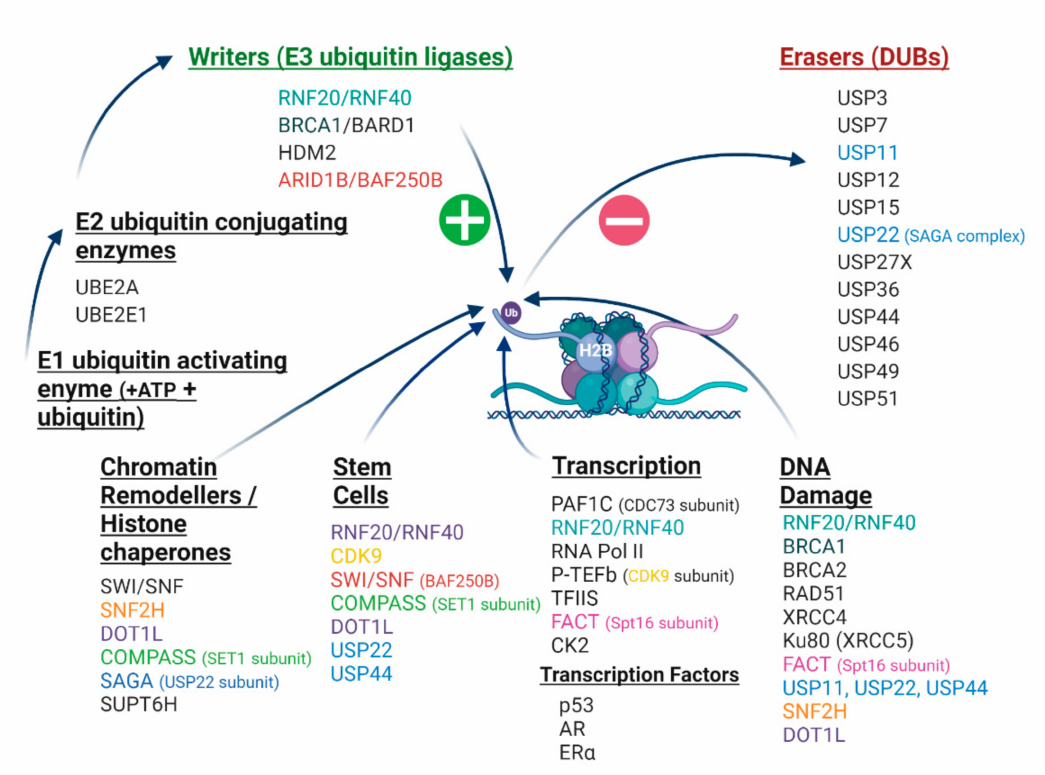
Figure 1. The H2Bub1 interactome. H2Bub1 can be written (green plus symbol) by multiple writer enzymes (E3 ubiquitin ligases) following an enzymatic ubiquitin cascade commencing with an E1 ubiquitin activating enzyme followed by an E2 ubiquitin conjugating enzyme. It can be removed (red minus symbol) by numerous erasing deubiquitinases (DUBs) from the Ubiquitin-Specific Protease (USP) sub-family. H2Bub1 interacts with a number of chromatin remodelling complexes and histone chaperones. Numerous components of the H2Bub1 interactome function in more than one cellular process, such as cyclin-dependent kinase 9 (CDK9) in stem cell plasticity and transcription, identified in this schematic by matching colours. The H2Bub1 interactome continues to be elucidated and is growing as new discoveries are made. Androgen receptor (AR); AT-Rich Interaction Domain 1B (ARID1B); BRG1 / BRM-associated factor (BAF250B); BRCA1-Associated RING Domain 1 (BARD1); Breast Cancer Type 1 (BRCA1); Breast Cancer Type 2 (BRCA2); cyclin-dependent kinase 9 (CDK9); estrogen receptor alpha (ER α ); complex of proteins associated with SET1 (COMPASS); disrupter of telomere silencing 1-like (DOT1L); facilitates chromatin transcription (FACT); Human Double Minute 2 (HDM2); X-ray Repair Cross Complementing 5 (Ku80, also known as XRCC5); RNA polymerase II-associated factor 1 complex (PAF1C); Positive Transcription Elongation Factor-b (P-TEFb); tumour protein 53 (p53); RNA polymerase II (RNA Pol II); RAD51 Recombinase (RAD51); RING Finger Protein 20 (RNF20); RING Finger Protein 40 (RNF40); Spt-Ada-Gcn5-acetyltransferase (SAGA); Su(var) 3–9 (SET1, suppressor of position e ff ect variegation), enhancer of zeste (E(z)), and trithorax (Trx); SNF2 homologue, (SNF2H, also known as SMARCA5); Suppressor of Ty Homologue-6 (SUPT6H); Switch / sucrose non-fermenting (SWI / SNF); transcription elongation factor II S (TFIIS); ubiquitin conjugating enzyme E2 A (UBE2A); ubiquitin-conjugating enzyme E2 E (UBE2E1); Ubiquitin-Specific Protease (USP); X-ray Repair Cross Complementing 4 (XRCC4). Created with